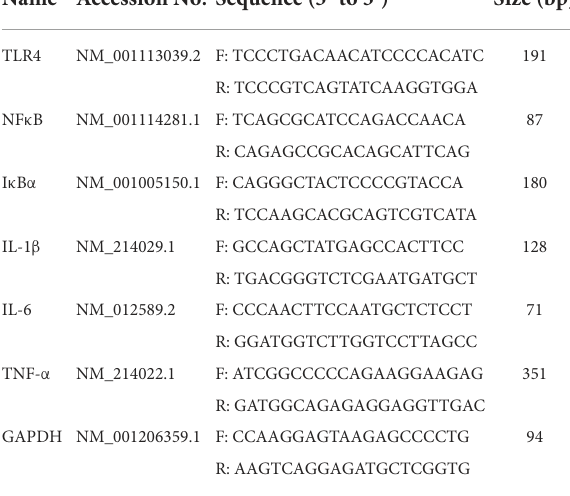
TABLE 2 Primer sequences used in real-time quantitative PCR. Name 1 Accession No. Sequence (5